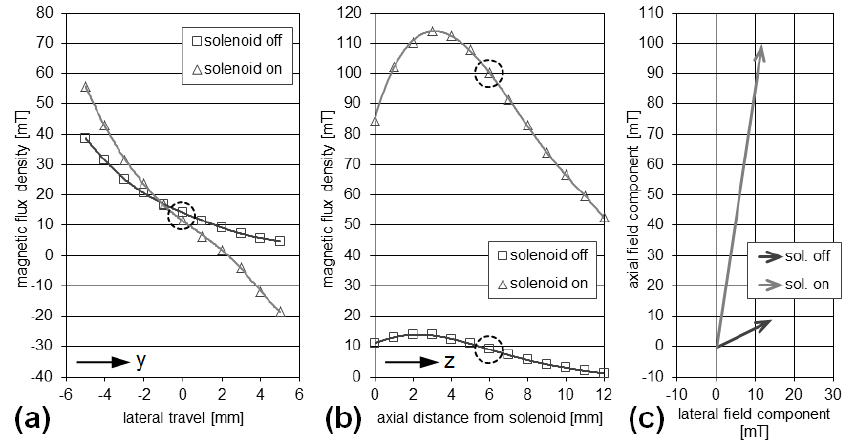
Figure 3. Magnetic field in the rMM-OCT setup. ( a ) Transverse magnetic field; and ( b ) longitudinal magnetic field measured with the solenoid turned off and on (30 V). The measurements were performed in the y–z plane with x = 0, as indicated in Figure 2b,c. The coordinate origin is again at the optical axis of the OCT probe ( x = y = 0 mm) and the surface of the solenoid ( z = 0 mm). The transverse field in ( a ) was measured at the working distance of the OCT probe ( z = 6 mm); The longitudinal field in ( b ) was measured along the optical axis of the OCT probe ( x = y = 0 mm). The focus position of the OCT beam along the optical axis ( x = y = 0 mm; z = 6 mm) is indicated by the dashed circles; ( c ) Resulting magnetic field vectors in the central OCT focus position ( x = y = 0 mm; z = 6 mm) during off- and on-states of the solenoid. The field vectors were calculated from the respective transverse and longitudinal magnetic field components indicated by the dashed circles in ( a , b ).